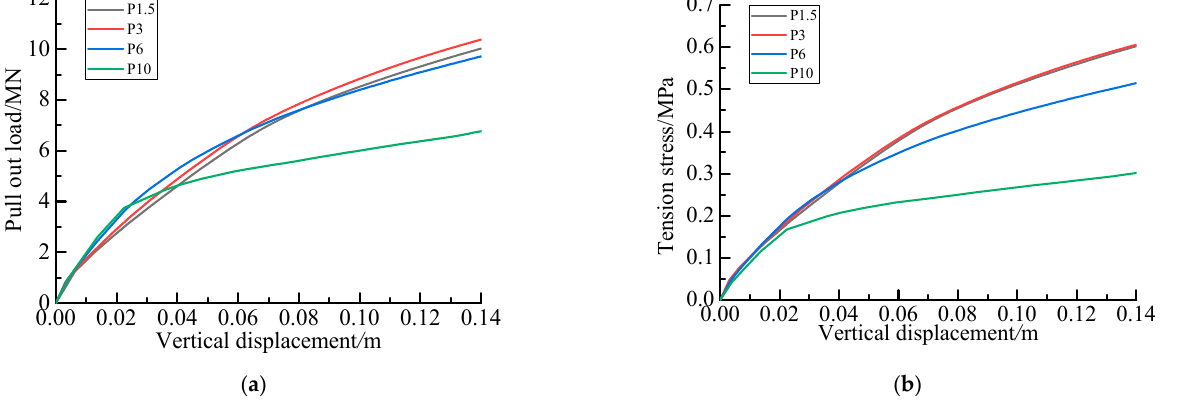
Figure 19. Uplift bearing characteristics of helical pile. ( a ) Load-displacement curves; ( b ) V/S -displacement curves.